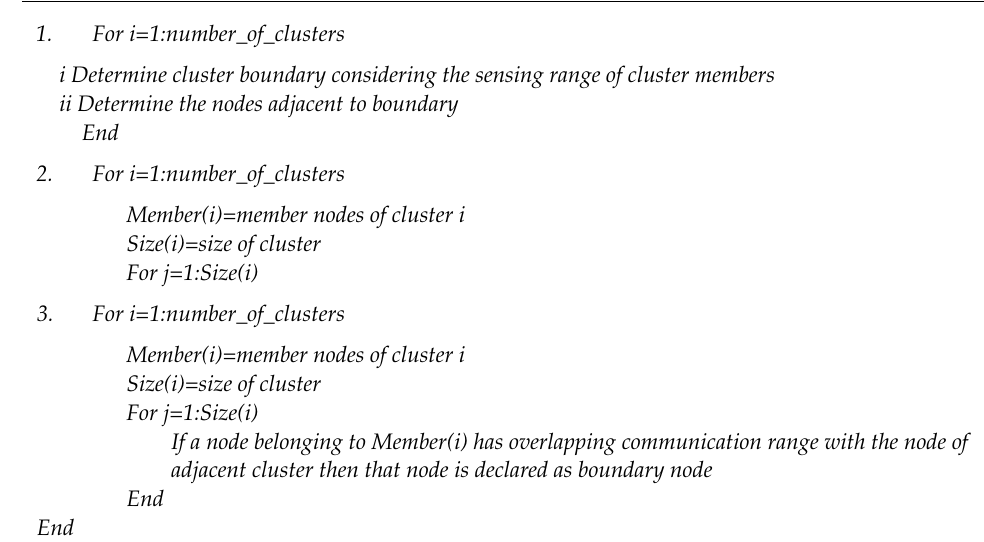
Algorithm 5 : Boundary node selection